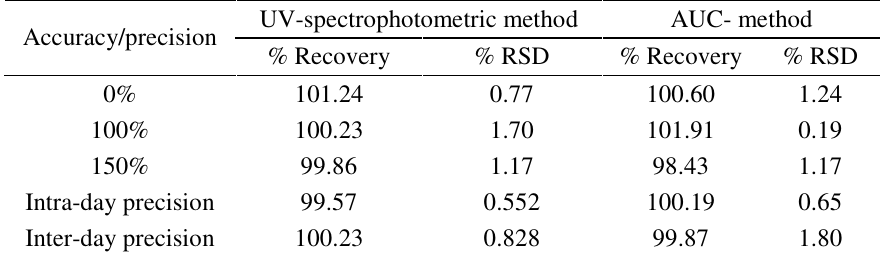
Table 3. Accuracy and precision of gemifloxacin mesylate by UV-spectrophotometric and AUC-